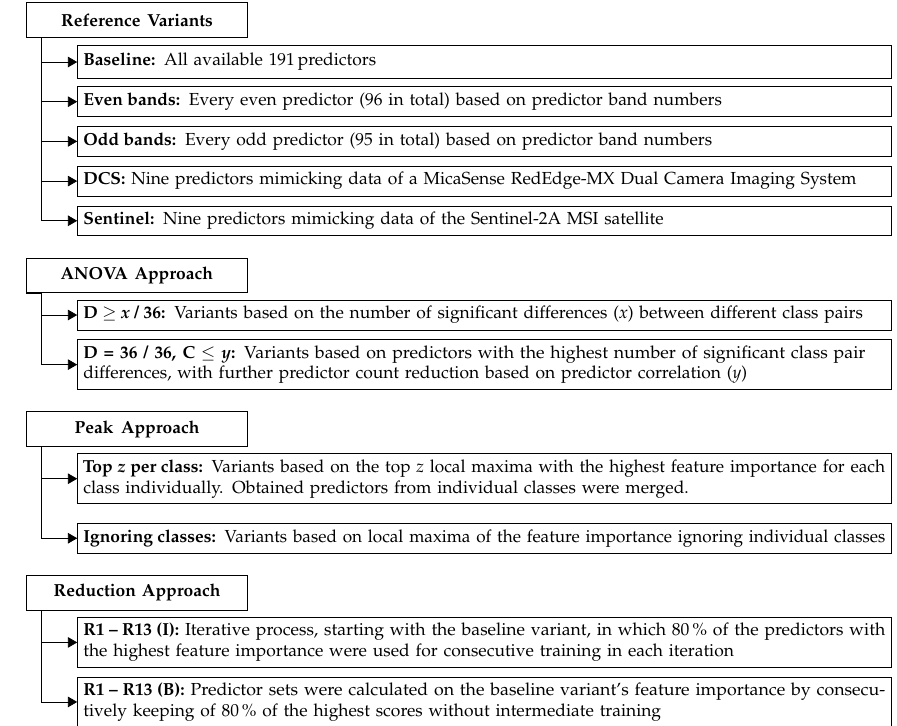
Figure 2. Schematic overview of dataset